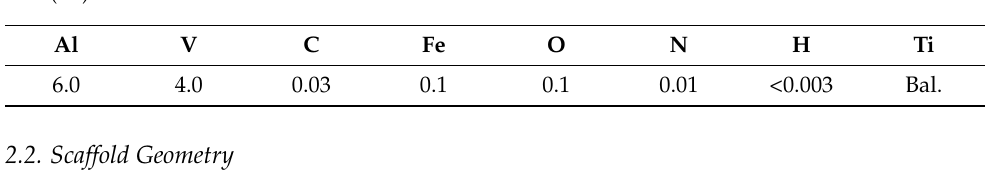
rhombic dodecahedron (RD, Figure 1B) elementary unit cell. Scaffold volume, indepen- dently on elementary unit cell geometry, corresponds to a cube 1 cm side